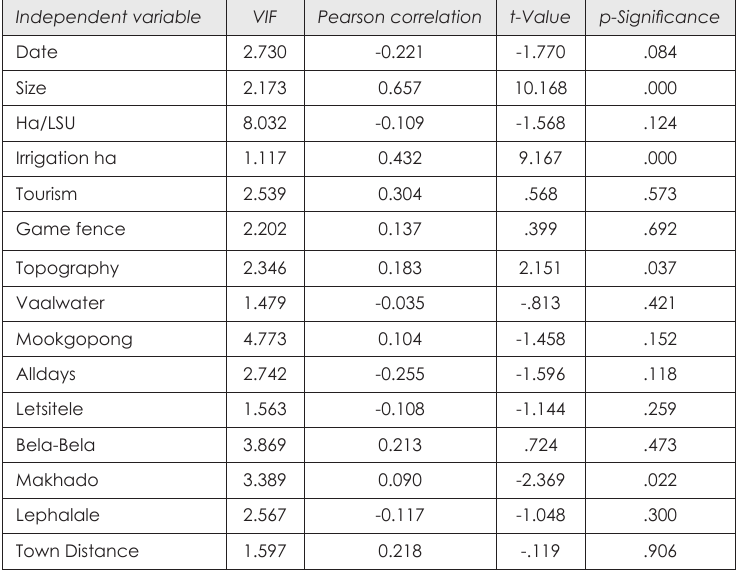
Model 2 regression correlations and